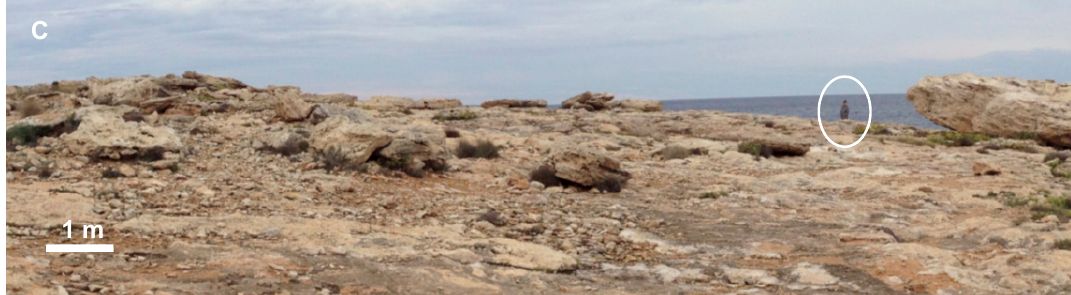
Figure 5. ( A ) Geomorphological scheme of the Punta Pedrera area. Roses show the prevailing wave direction. (B) Large coastal boulder located 10 m a.s.l. ( C ) Boulder ridge at Punta Pedrera. Notice the person in the cercle.